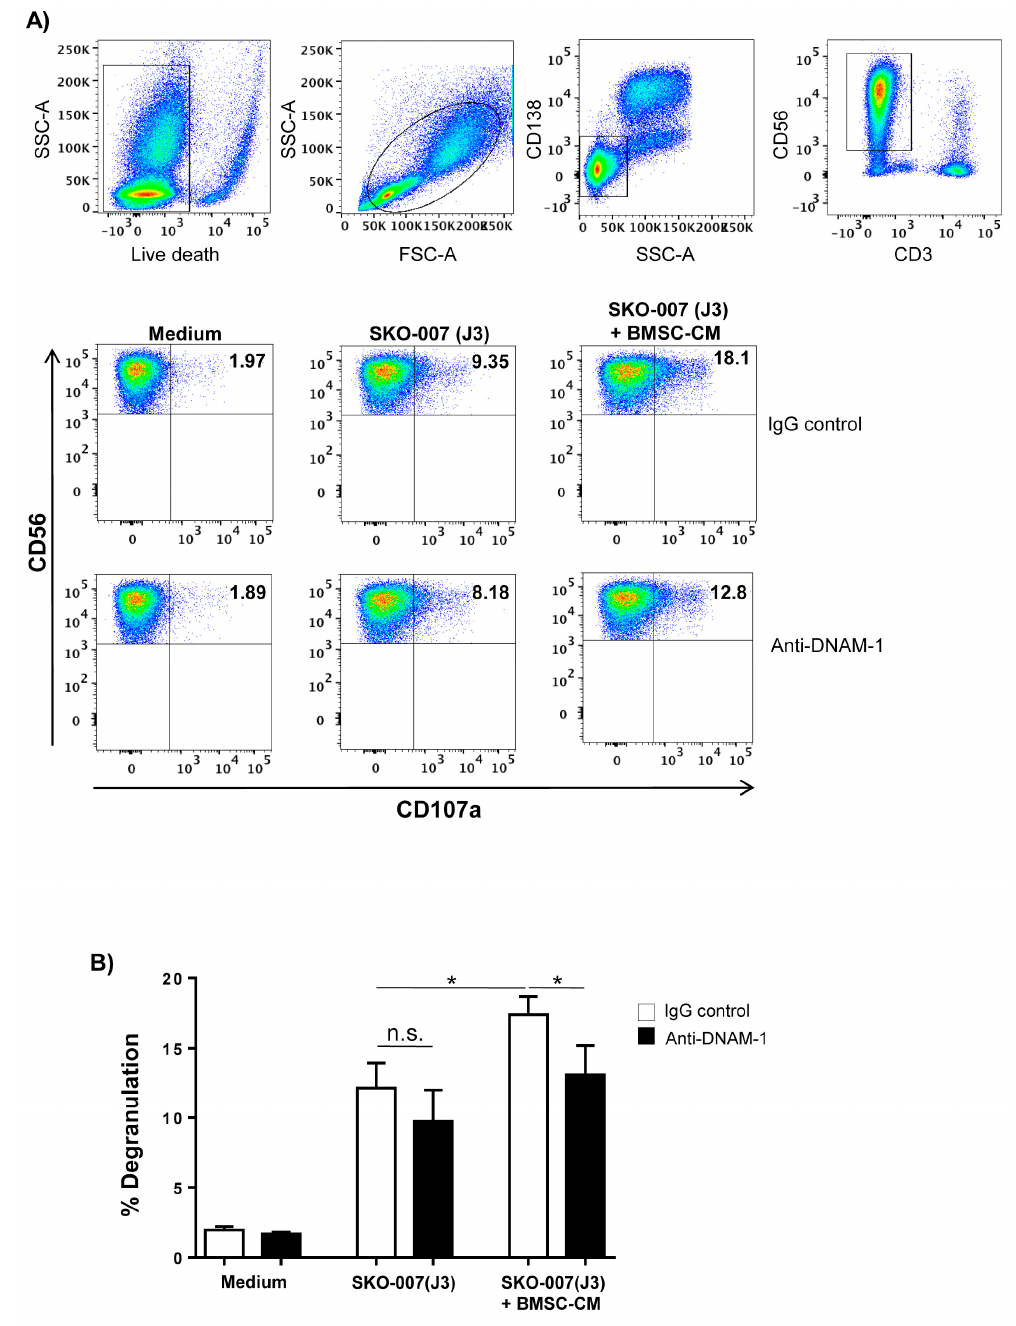
Figure 2. BMSCs enhance the ability of MM cells to stimulate NK cell degranulation by promoting DNAM-1 recognition. NK cells derived from PBMCs of healthy donors were incubated with SKO-007(J3) cells, untreated or cultured for 72 h with BMSC-CM and used as target cells in a degranulation assay. The assay was performed at the e ff ector-target (E / T) ratio of 2.5:1. Cell surface expression of CD107a was analysed on CD3 − / CD138 − / CD56 + NK cells. The gating strategy used in flow cytometry analysis is shown in ( A ). To evaluate the role of DNAM-1, the assay was performed in parallel treating NK cells with blocking anti–DNAM-1 or anti-IgG mAbs used as control. Results are expressed as the percentage of CD107a + cells. A representative experiment is shown. ( B ) Histogram represents the mean ± SD from three independent experiments (* p < 0.05,